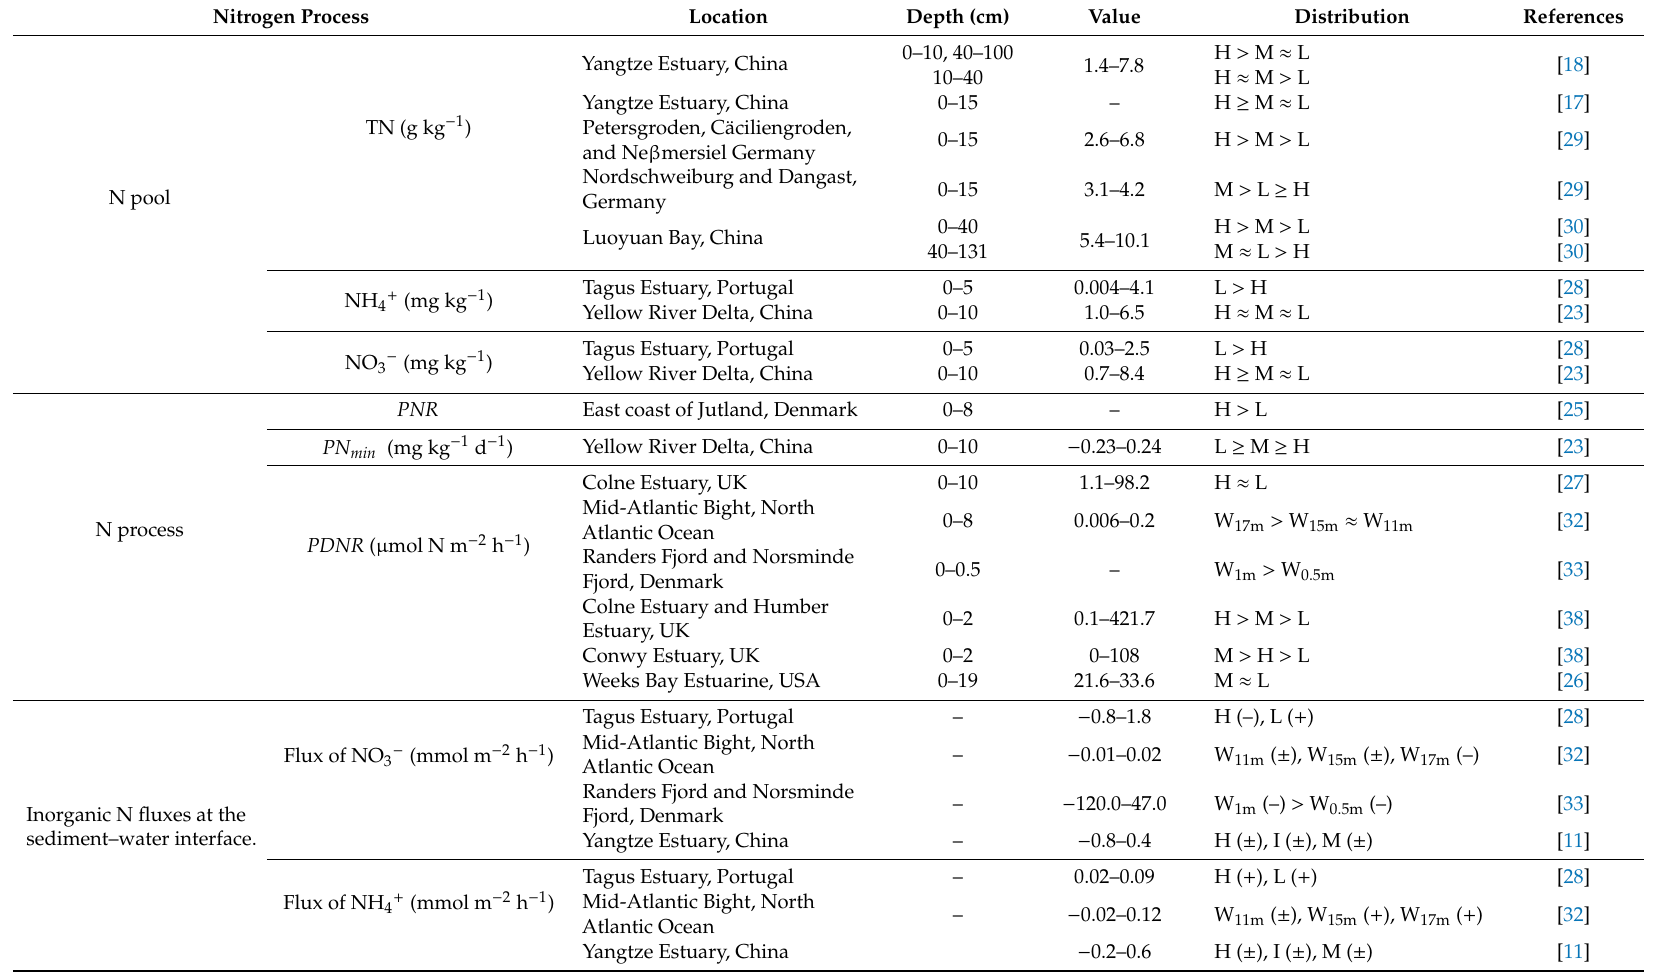
Table 1. Nitrogen pool, process, and flux along the gradient of di ff erent intertidal